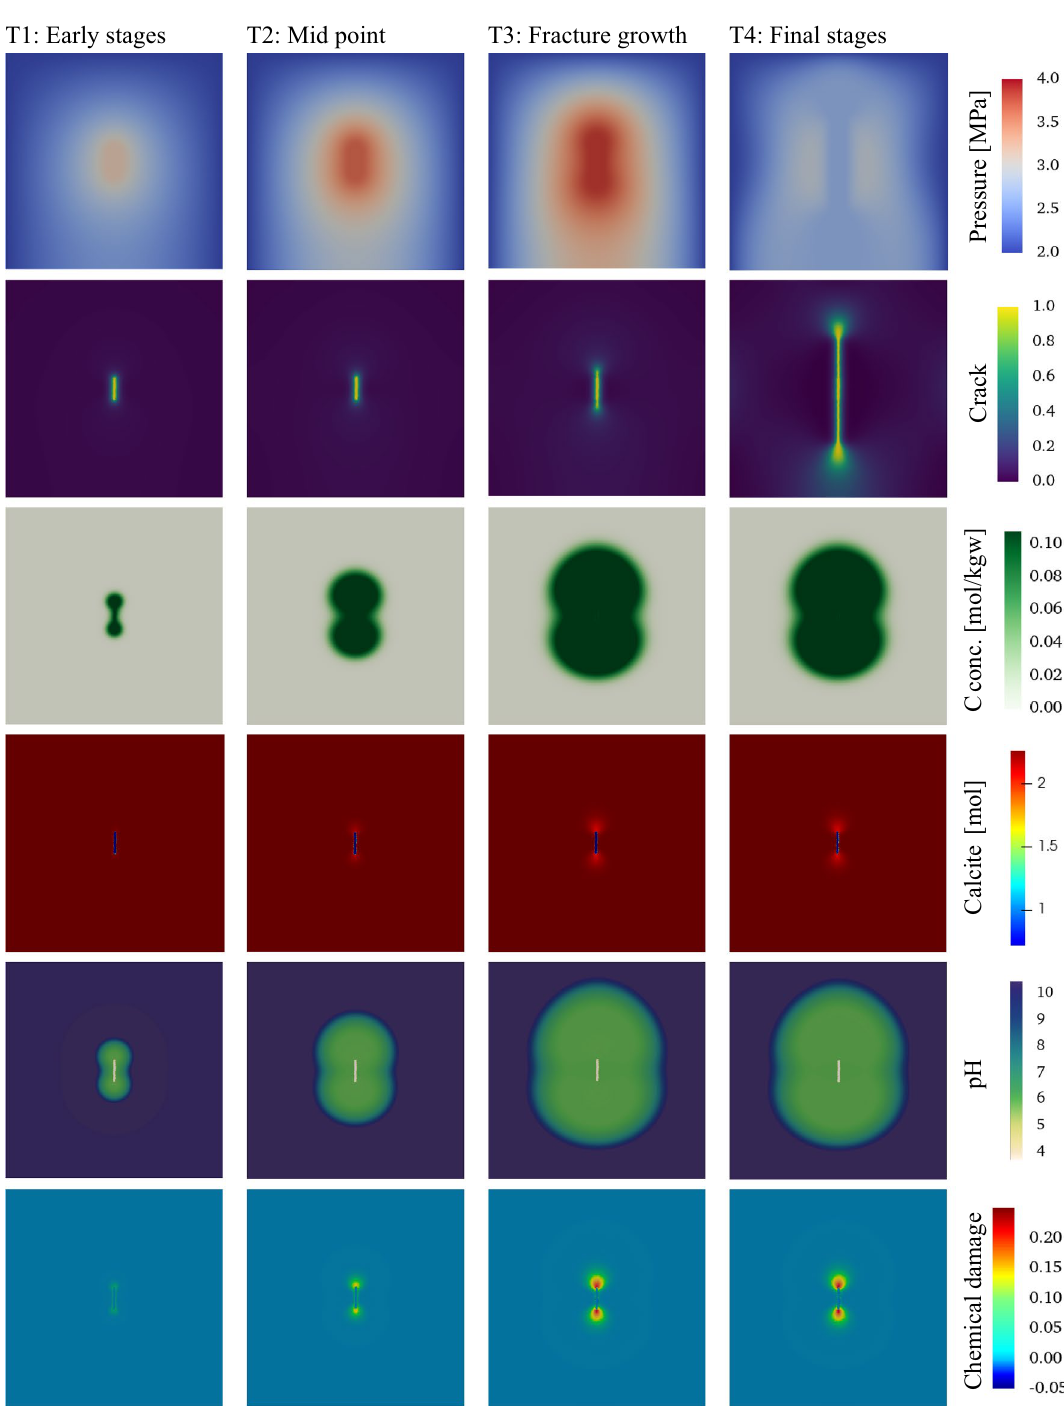
Figure 7. Contour plots showing different variables corresponding to fracture propagation at different times (T1-T4), where continuous injection of CO 2 leads to pressure buildup and calcite